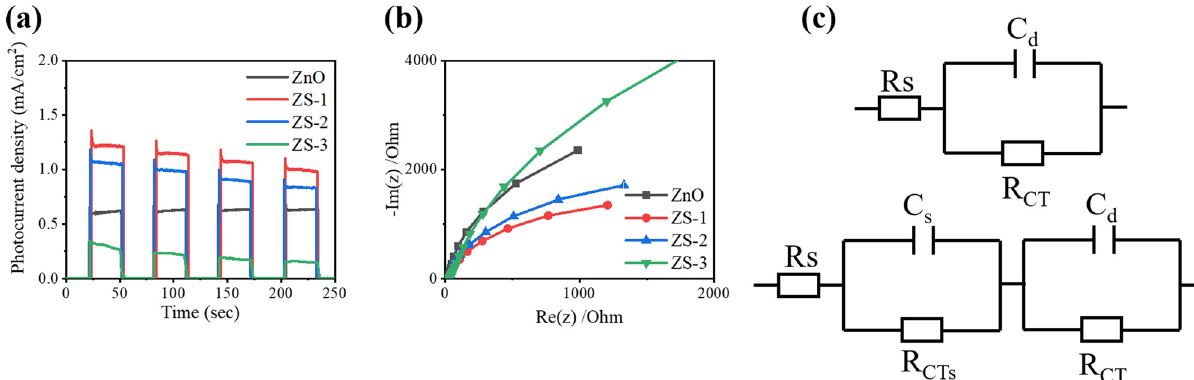
Figure 8: ( a ) Chronoamperometric I – t curves collected at 0.5 V vs Ag/AgCl for various products under chopping irradiation. ( b ) Nyquist plots of various products under irradiation. ( c ) The possible equivalent circuits employed to fi t the Nyquist plots of various products. The upper one is for the ZnO template, and the lower one is for the ZnO – ZnS